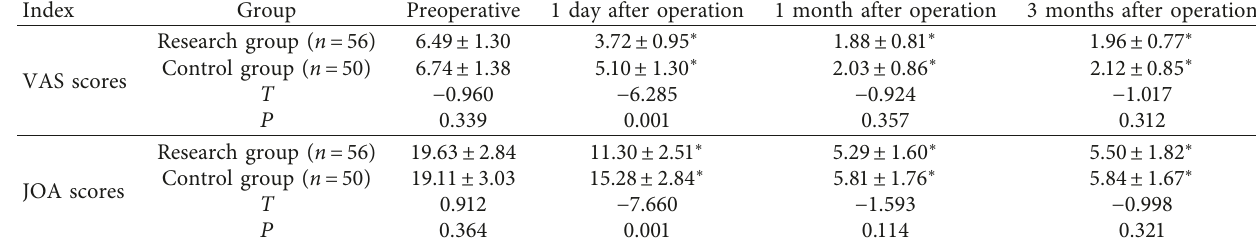
Figure 1: Comparison of surgical trauma indexes between the two groups. (a) Surgical incision length. (b) Intraoperative blood loss. (c) Operation time. (d) Hospital stay. Table 3: Comparison of the VAS score and JOA score between the two groups (x